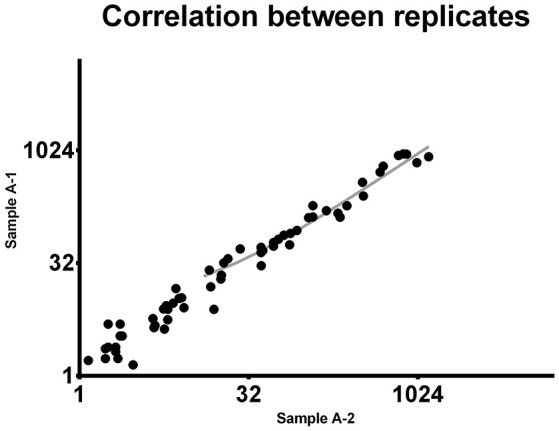
Correlation between replicates. The same 92-miRNA panel was assessed twice in the same sample. Results were highly concordant (Pearson r = 0.9537). Each dot represents a microRNA. The miRNA absolute expression is presented as copies per microliter of the amplification reaction mixture. Axis scale is log2 transformed.